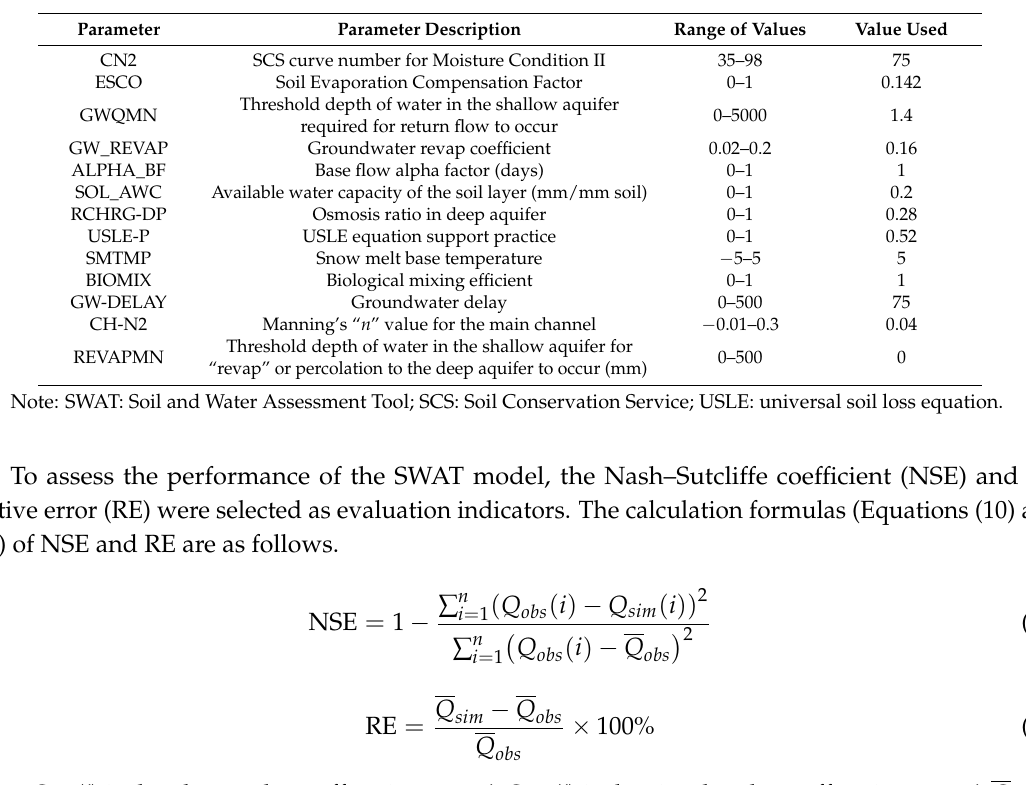
Threshold depth of water in the shallow aquifer required for return flow to